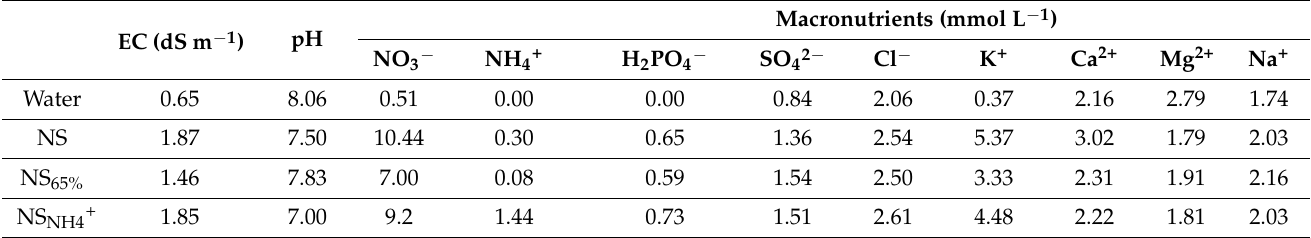
Table 1. Chemical composition of the water irrigation and nutrient